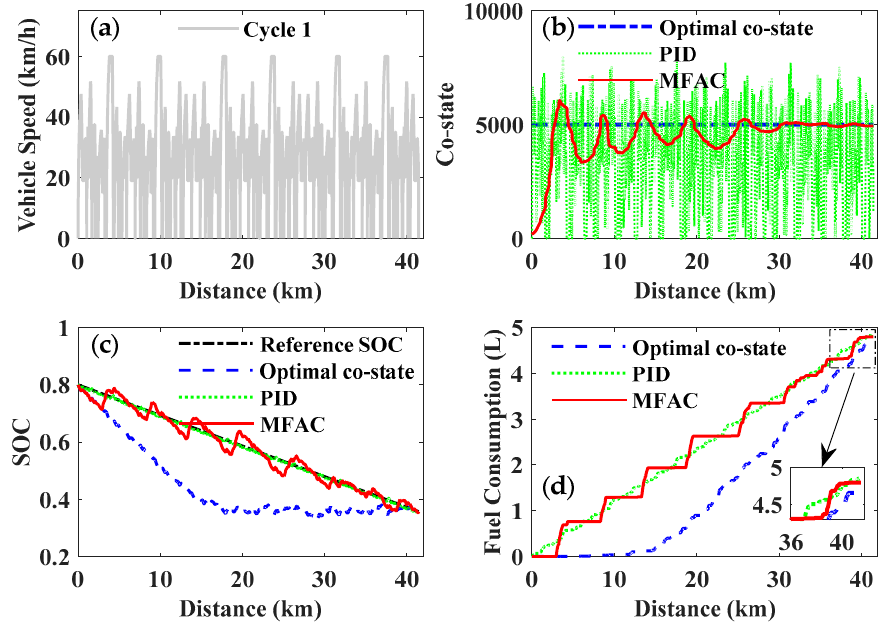
Figure 18. The simulation results of driving Cycle 1. ( a ) Driving cycle; ( b ) Co-state; ( c ) SOC; ( d ) Fuel consumption.